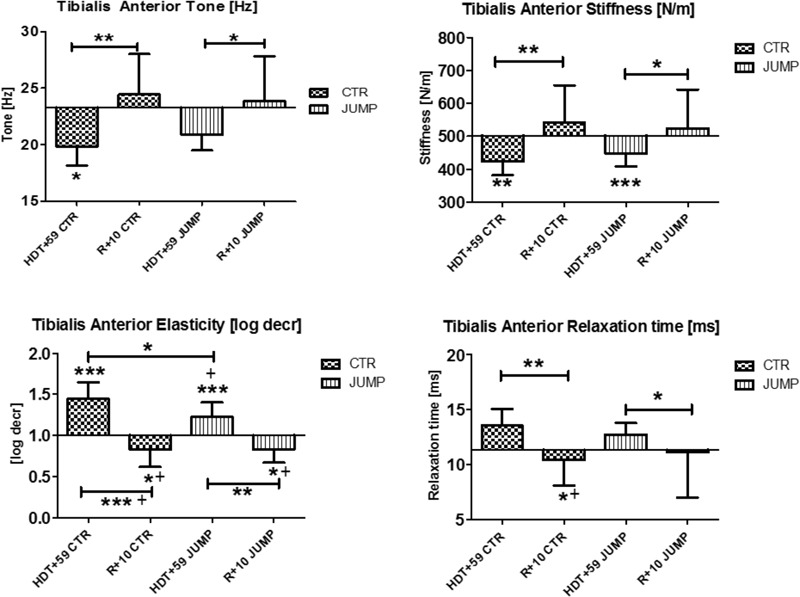
Tibialis anterior (MP9/10). Oscillation signal patterns in RSL bed rest study. P-values (asterisks) refer to each graph. Error bars = SD (standard deviation). ABD = average baseline data (Tone HDT+1 = 23.29; Stiffness HDT+1 = 502.43; Elasticity HDT+1 = 1.0; Relaxation HDT+1 = 11.33). ∗p < 0.05, ∗∗p < 0.01, ∗∗∗p < 0.001 ± SD, +Spearman ρ.